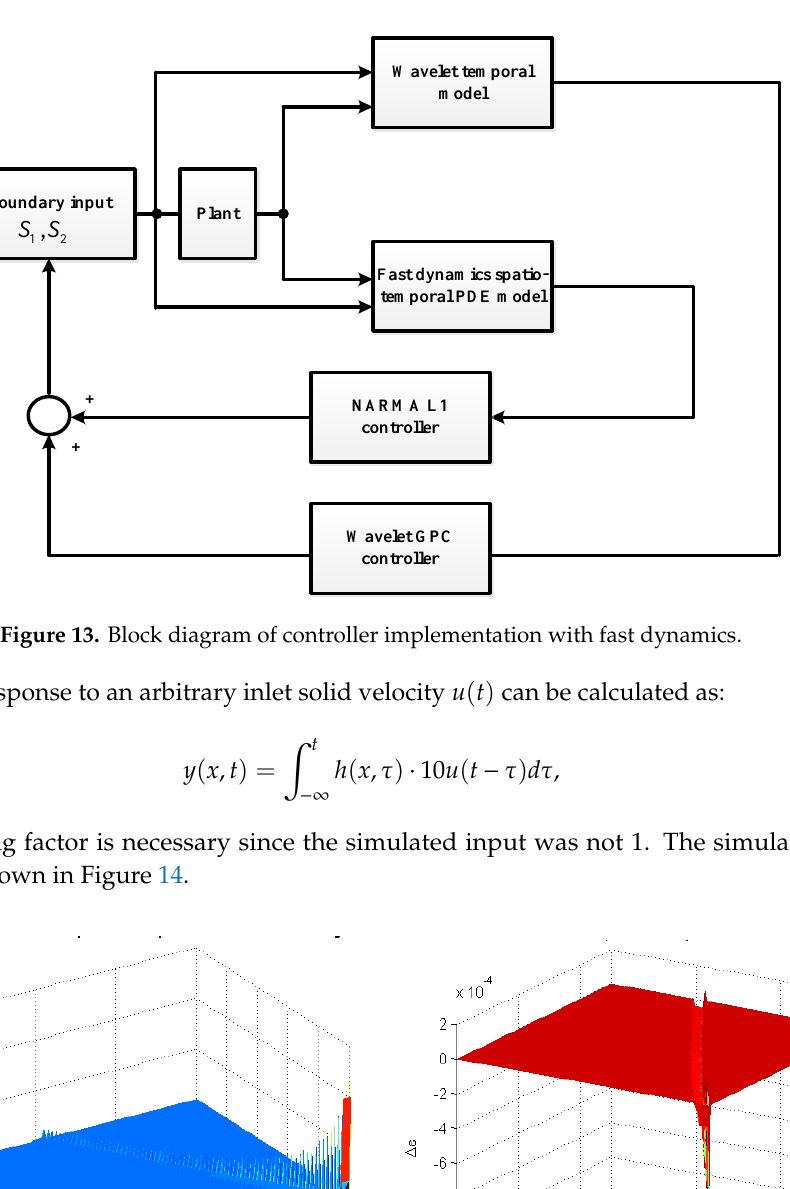
Figure 13. Block diagram of controller implementation with fast dynamics.